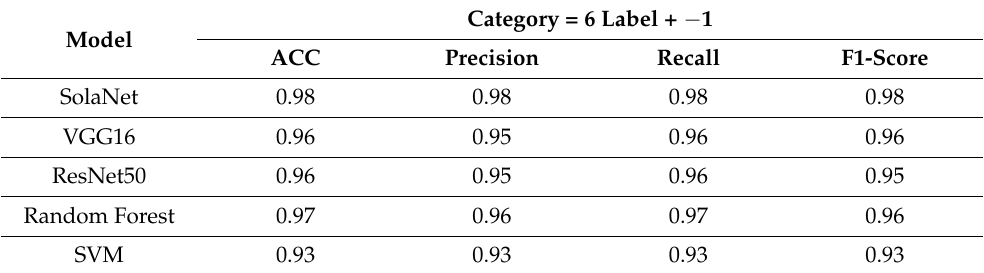
Table 4. Performance summed up the +1 and − 1 of SolaNet and other popular models.